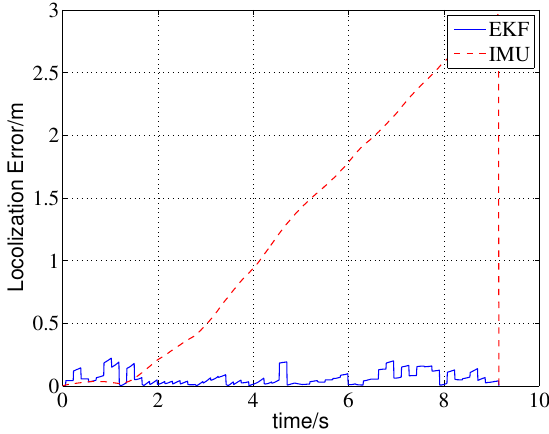
Figure 13. Localization